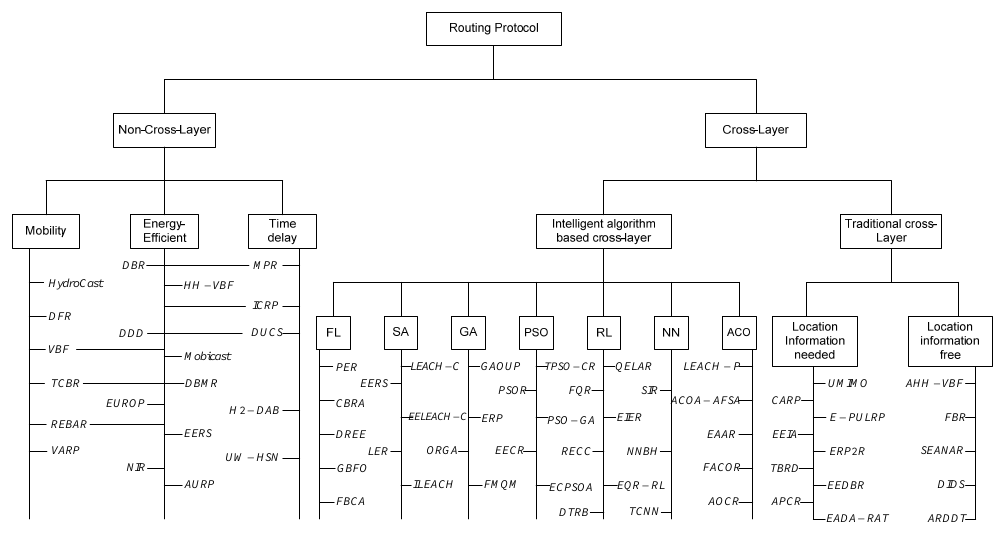
Figure 1. The classification of UASN routing protocols.